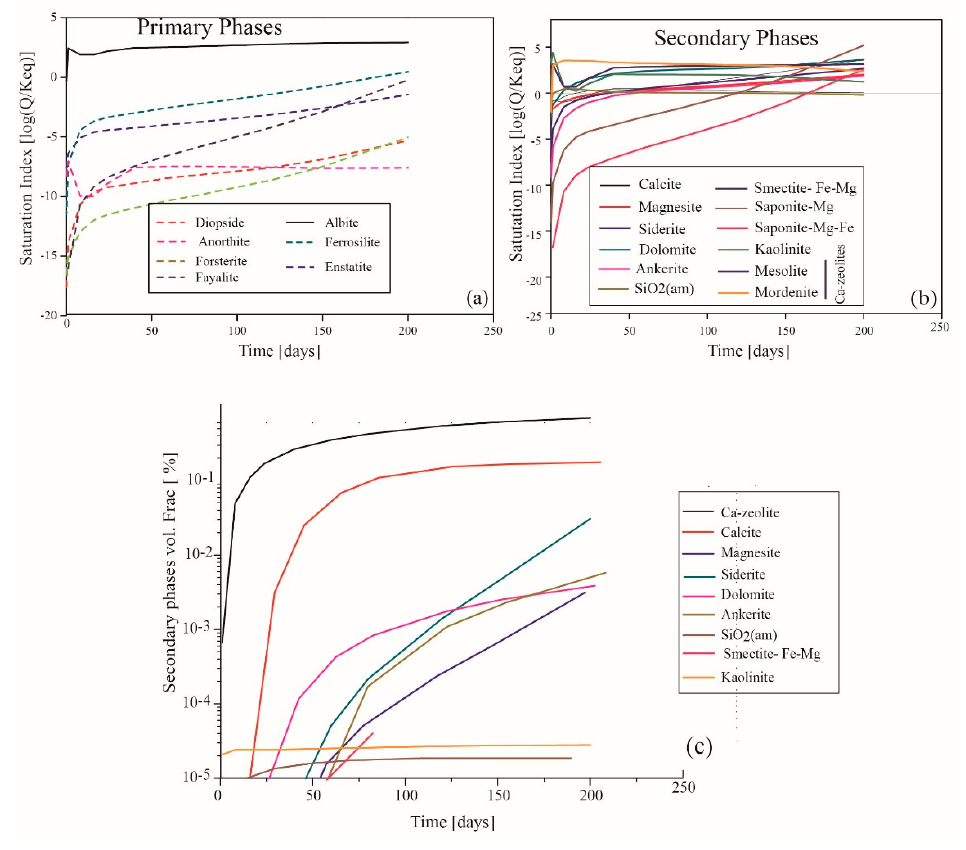
Figure 9. Evolution of the simulated saturation index: for the primary ( a ) and secondary minerals ( b ) and the variation of minerals’ volume fraction (in m 3 mineral / m 3 rock) vs. time ( c ). Table 8. Simulated dissolution and precipitation rate at t = 200 days (simulation with specific surface areas (SSA) = 120 cm 2 · g − 1 ).